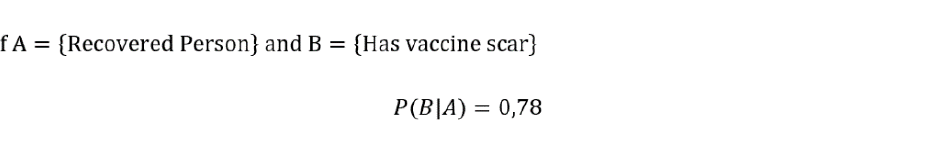
Figure 7. The practice of Team 5 of prospective teachers (G3) on Activity 2 (retrieved from [37]).